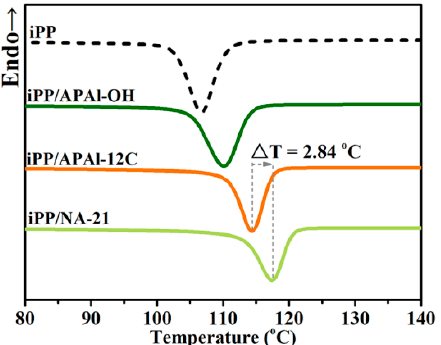
Figure 4. The DSC curves for the iPP composites.